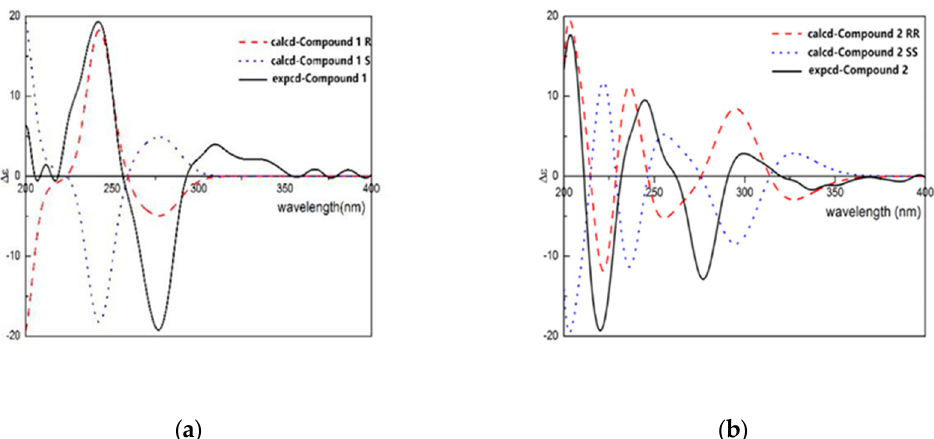
Figure 2. HMBC correlations of compounds 1 ( a ) and 2 ( b ).